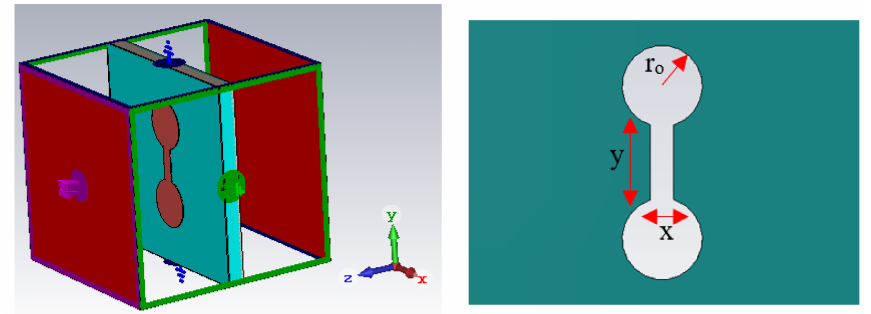
Figure 11 . Model current distribution (J n1 – J n4 ) of the proposed MIMO configurations ( a ) Ant. A, ( b ) Figure 11. Model current distribution (J n1 –J n4 ) of the proposed MIMO configurations ( a ) Ant. A, Ant. B, and ( c ) Ant. C . ( b ) Ant. B, and ( c ) Ant. C.